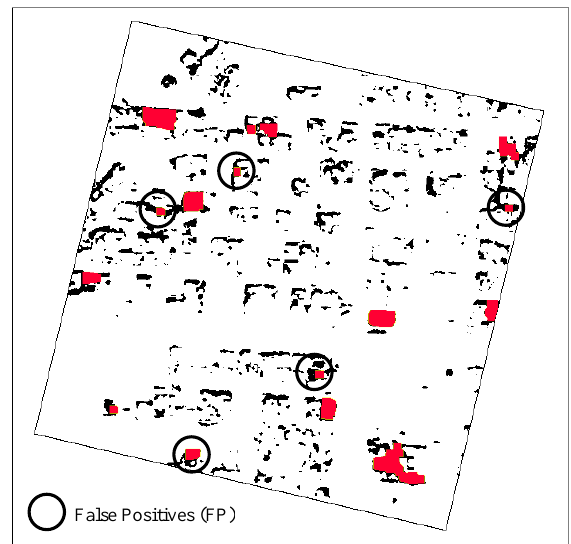
Figure 10. Change map after refinement by morphologic opening. The 16 areas in red constitute building change.